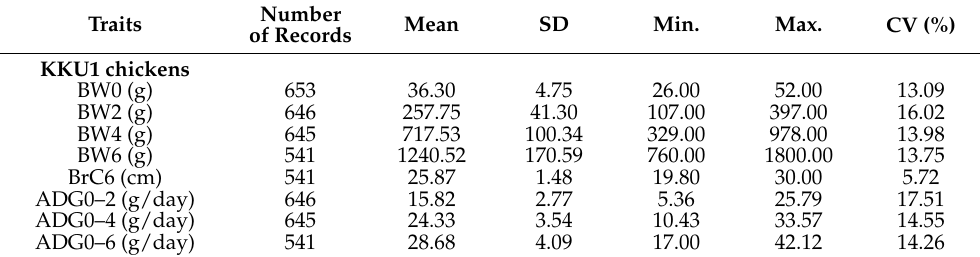
Table 1. Descriptive statistics of the growth performance traits in crossbred Thai indigenous chickens. Number Traits of